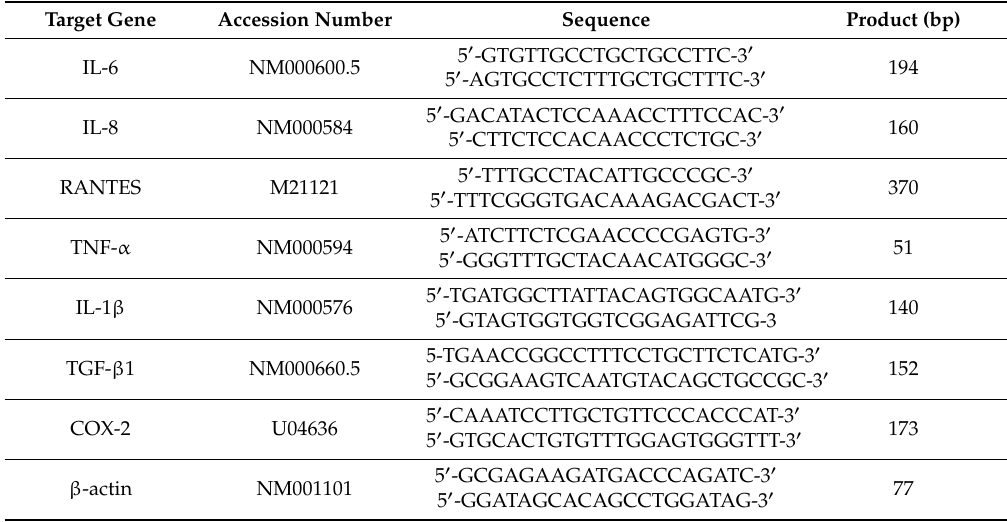
Table 1. Primer sequences and lengths of amplified templates for real-time quantitative polymerase chain reaction (PCR)